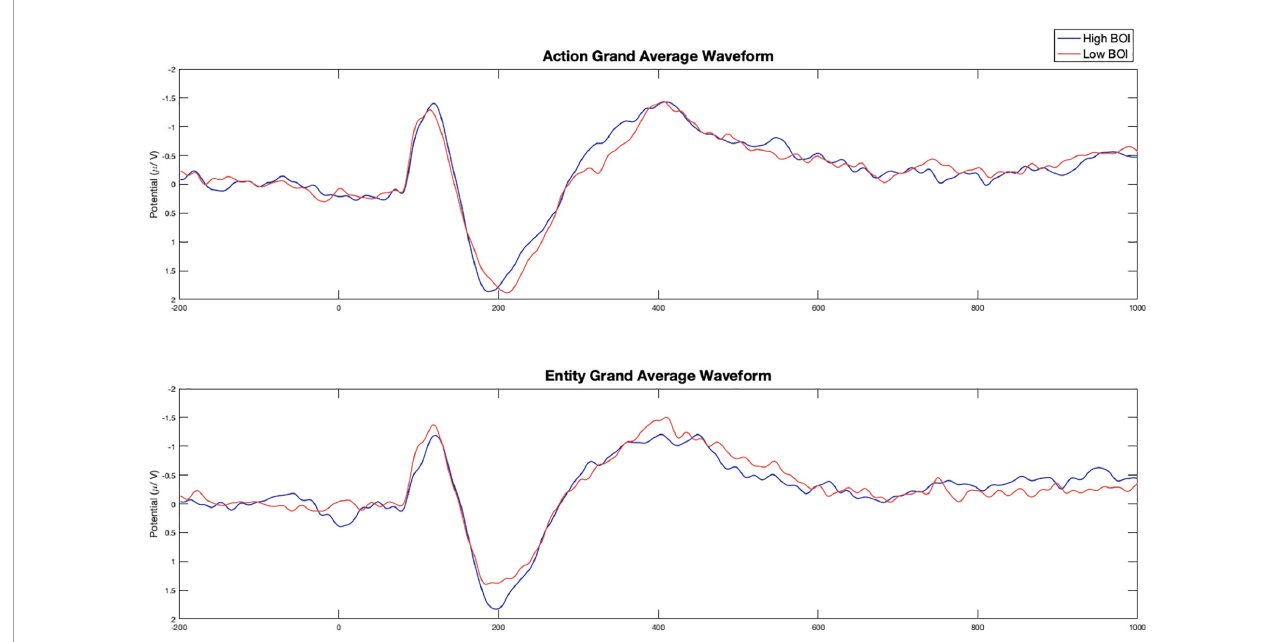
FIGURE1 Experiment 2 grand averaged event related potentials (ERPs) across all electrodes by task condition and word type. Grand average was calculated from a pre-defined central cluster of electrodes (FC1, FCz, FC2, C1, Cz, C2, CP1, CPz, and